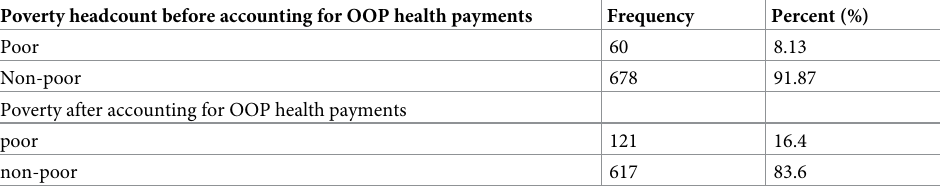
Note: Estimates were generated at household level. The households of all the 744 patients were included in the analysis. Poverty headcount was computed at the World Bank recommended $1.90 per